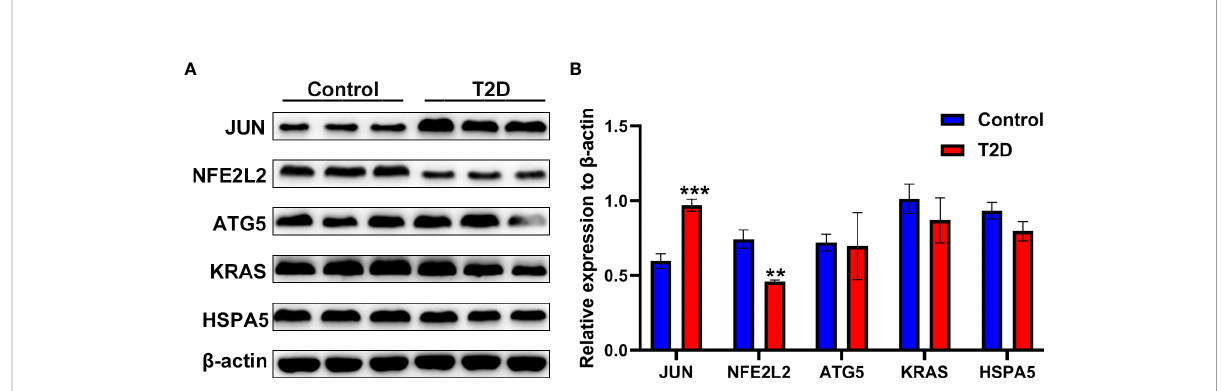
FIGURE 12 The protein expression levels of ferroptosis-related hub genes in a rat model of T2D. (A) The western blotting results of the protein expression levels of JUN, NFE2L2, ATG5, KRAS and HSPA5 in pancreatic tissues of a rat model of T2D generated by a high-fat diet and streptozotocin. (B) Semi-quantitative analysis of immunoblotting results of JUN, NFE2L2, ATG5, KRAS and HSPA5 in pancreatic tissues. ** P < 0.01, *** P < 0.001 vs. control